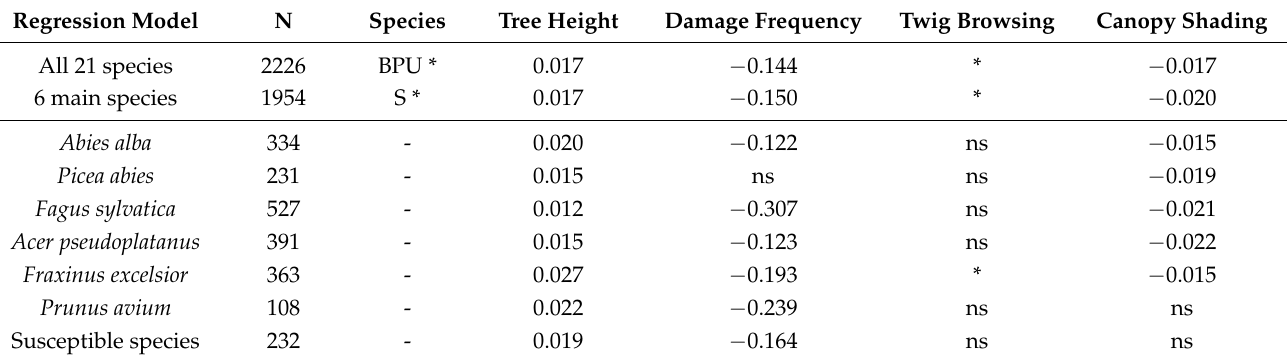
Table 2. Regression model for the height increment in 2021 for saplings of height class (HC) 1 to